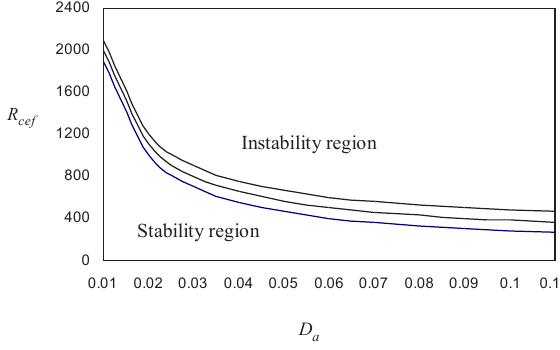
Fig. 3. The variation in the critical thermal Rayleigh number R with the couple -stress parameter D